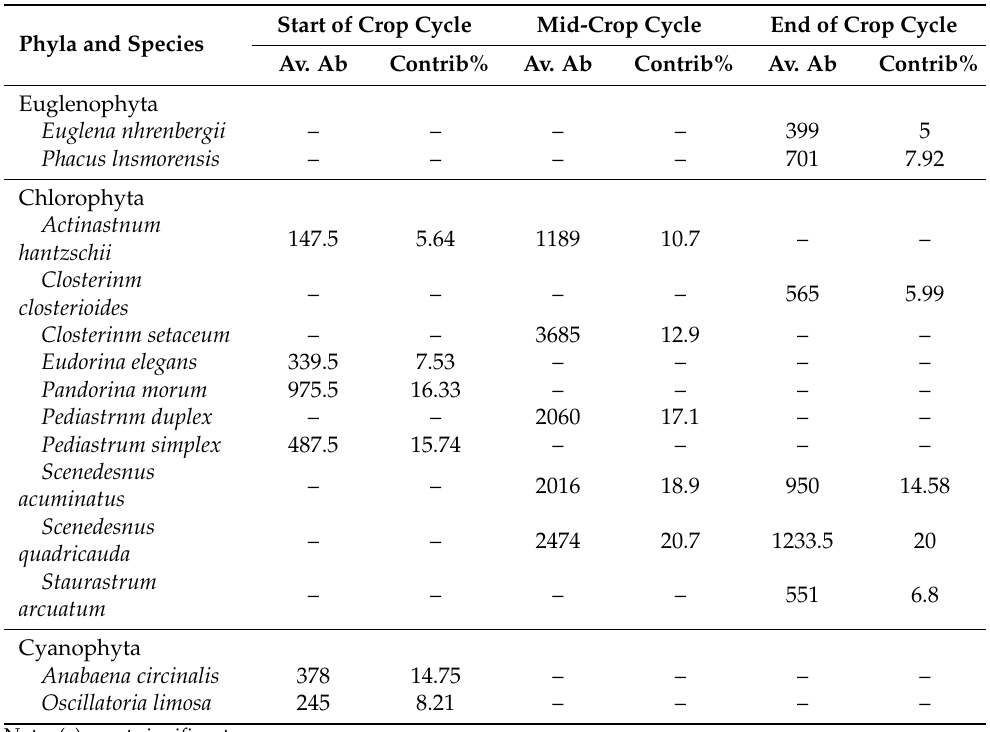
Table 3. The dominant species of phytoplankton in each